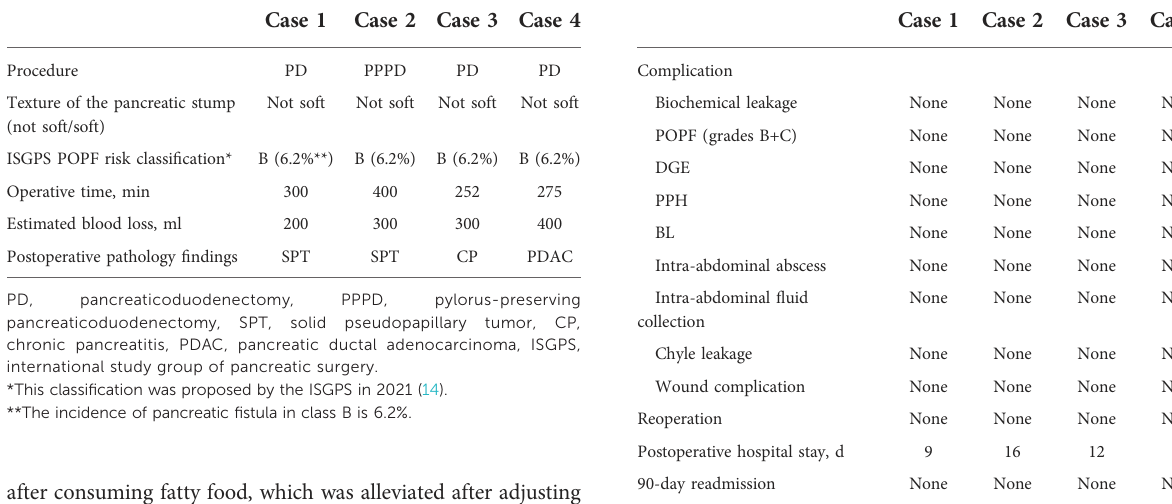
TABLE 2 Intraoperative data and postoperative pathology fi ndings. TABLE 3 Postoperative course and